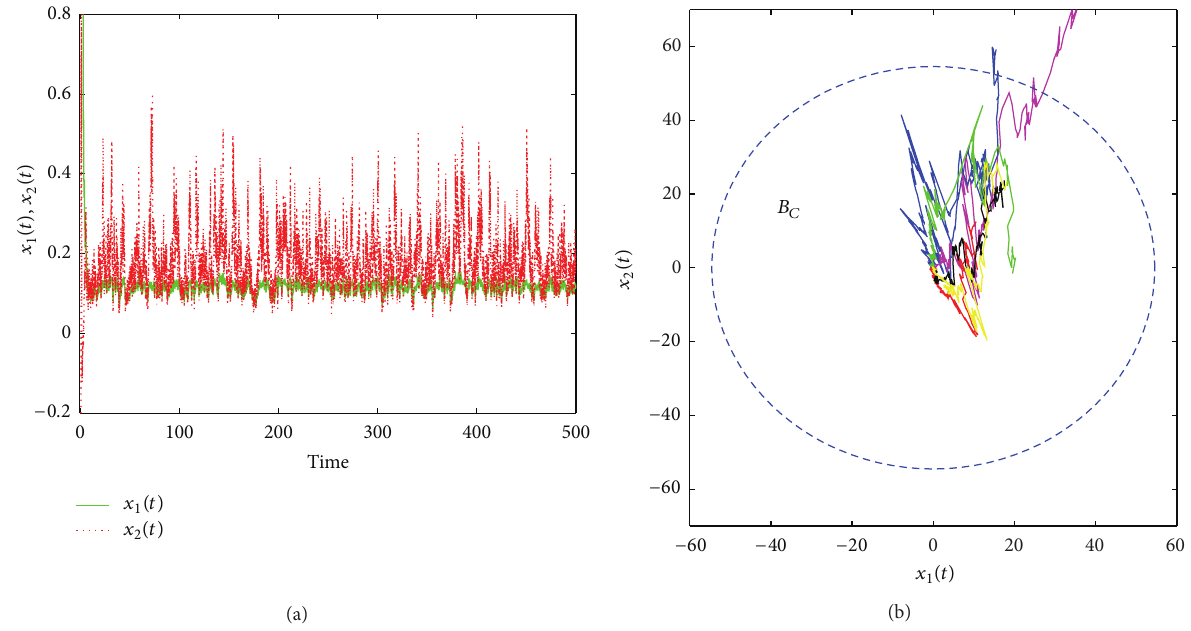
Figure 1: Time trajectories (a) as well as the set 𝐵 𝐶 and several typical phase portraits (b) for the system in Example 8 (color online). Where initial values for 𝑡 < 0 are chosen as 𝑥(𝑡) = (50, 80) . For (b), only phase portraits for 𝑡 ≥ 0 are